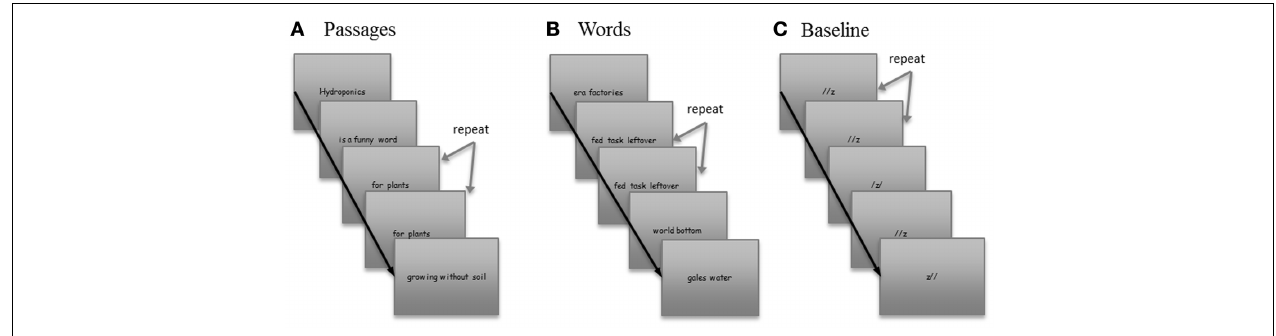
FIGURE 1 | Sample stimuli from each of the three conditions. Stimuli consisted of three conditions, (A) Passages, (B) Words, and (C) Baseline. Order of three conditions was defined by two order lists which were randomly administered to